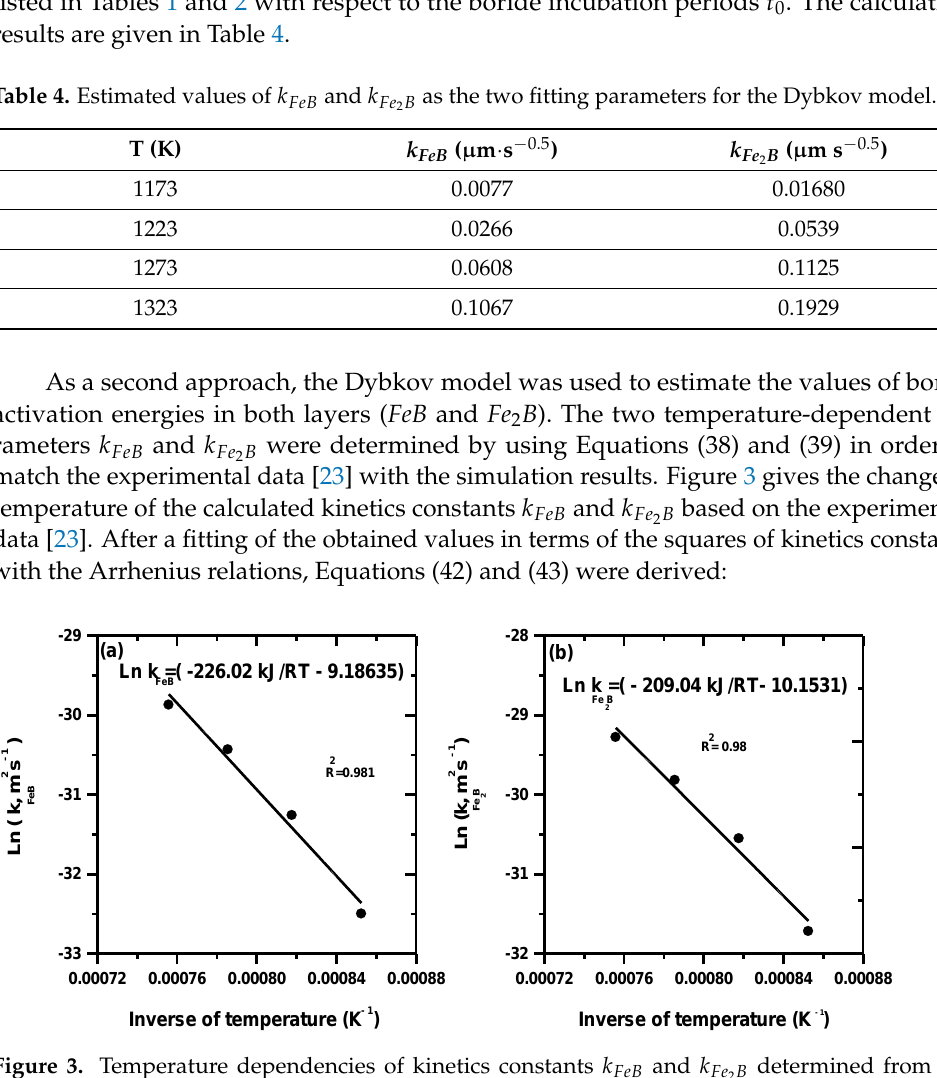
k and k as the two fitting parameters for the Dybkov mod- FeB BFe 2 as the two fitting parameters for the Dybkov model. 2 B